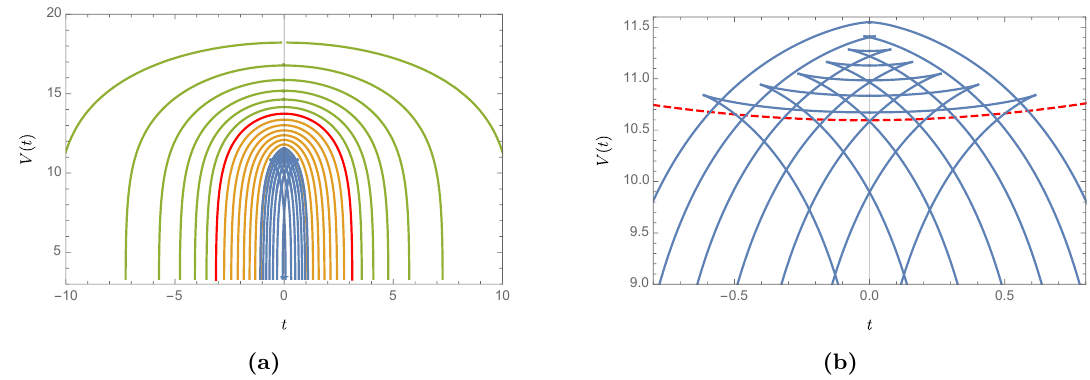
Figure 10. Volume as a function of the boundary time t for the different γ -centaur geometries with R b = 100 . In (a), the outermost green curve corresponds to φ 0 = 0 . 7 and adjacent green, red and yellow curves correspond to decreasing φ 0 in jumps of − 0 . 1 up to φ 0 = − 0 . 7 . The green curves correspond to φ 0 > 0 , and the yellow ones to φ 0 < 0 . The thicker red curve φ 0 = 0 , corresponds to the centaur geometry from the previous section. For smaller φ 0 we plotted curves in blue from φ 0 = − 0 . 74 to φ 0 = − 0 . 99 in steps of − 0 . 05 . In (b), we zoom in this last region, showing the √ different behaviour of curves with φ 0 < − 1 / 2 ∼ − 0 . 7 . In dashed red, we show the analytic result for the AdS black hole and we see how as φ 0 approaches − 1 , the curves tend to the one of the black hole, but only for short times. They never admit linear